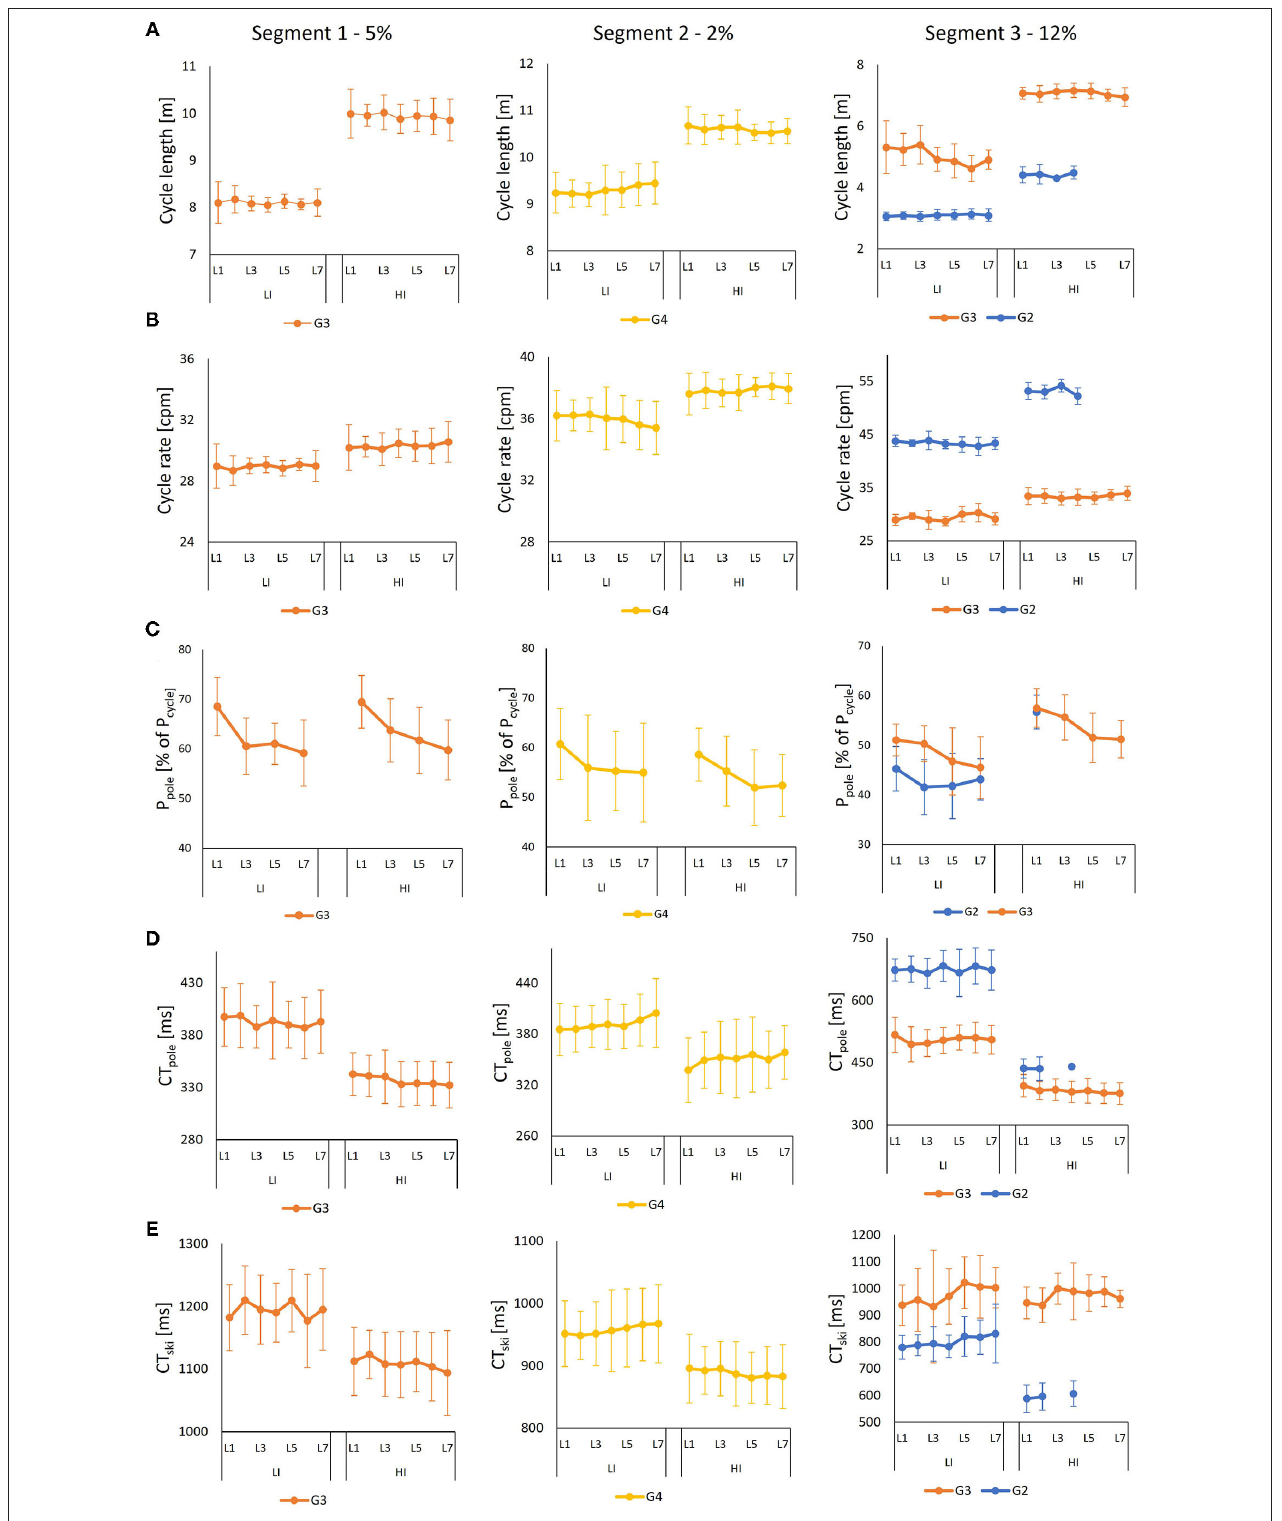
FIGURE 6 | (A) Cycle length (CL), (B) cycle rate (CR, in cycles per minute, cpm), (C) relative power contribution from pooling (in % of total power for each cycle), (D) contact time for pole (CT pole ), and (E) contact time for ski (CT ski ), all variables as a function of the lap (i.e., L1–L7) during the LI and HI sessions for each